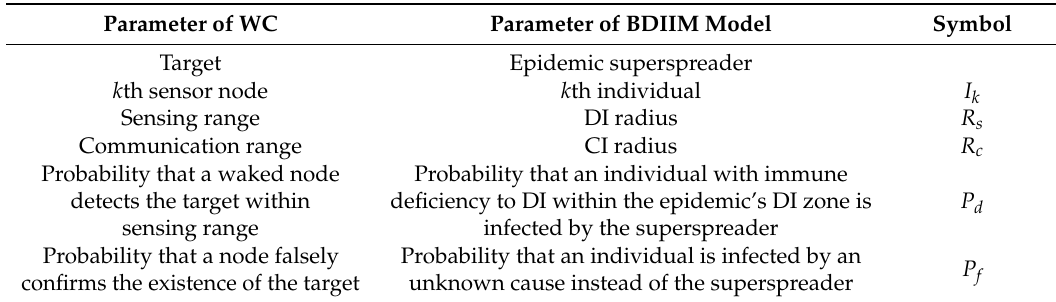
Table 1. Parameter correspondence between the BDIIM and the sensor nodes.